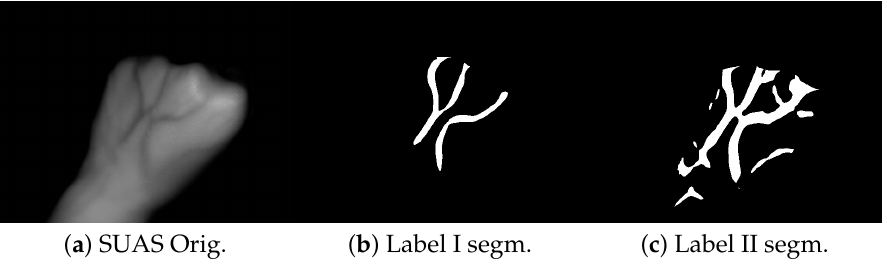
Figure 26. Segmentation of the ensemble on the SUAS database.